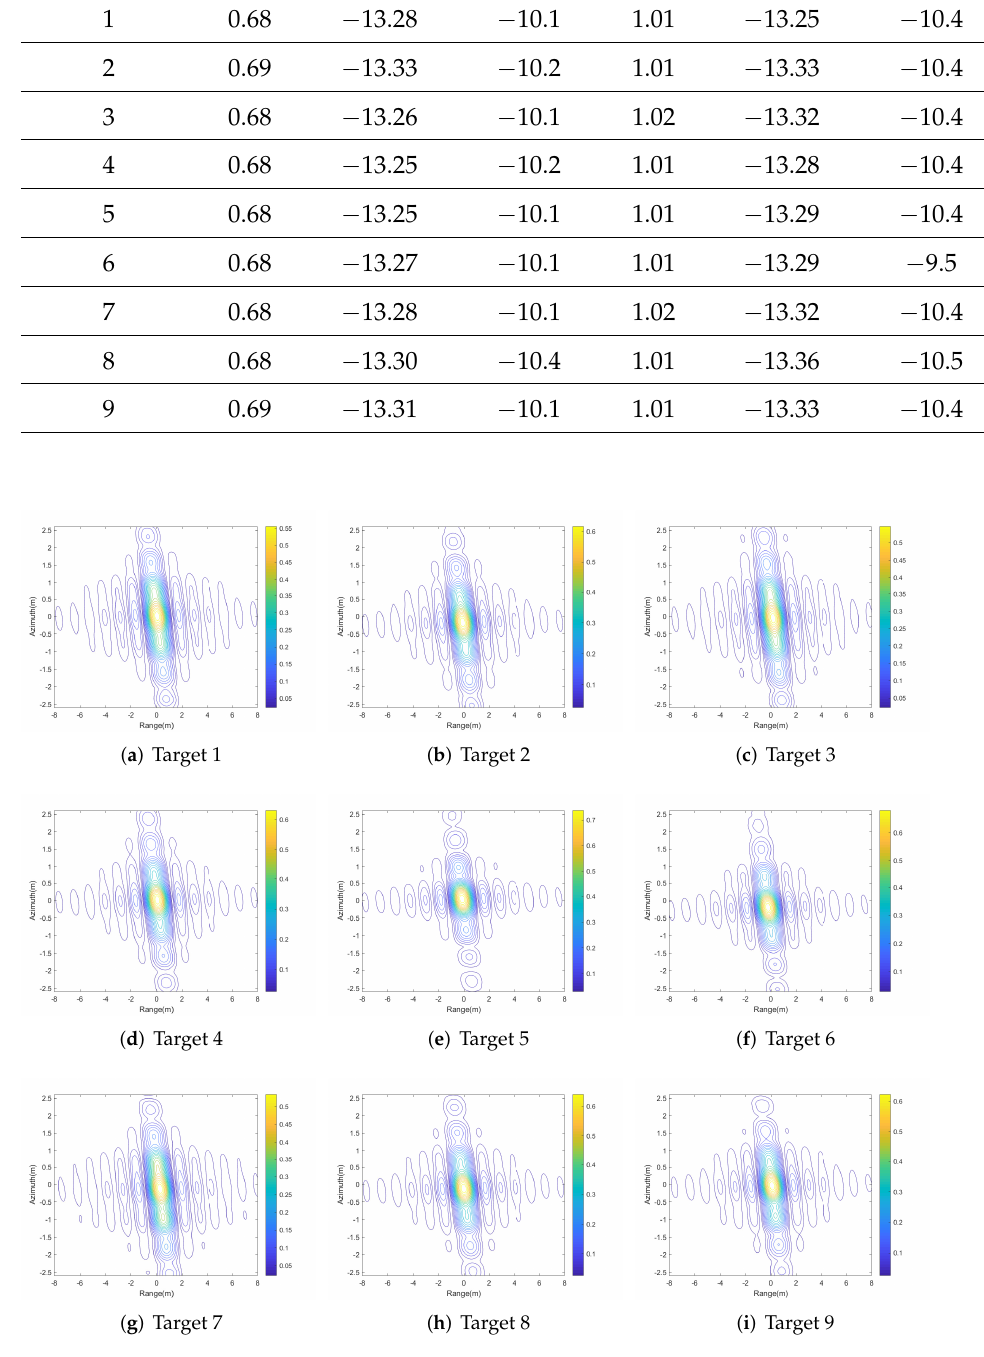
Figure 8. Imaging results of the nine point targets by the ‘non-stop-and-go’